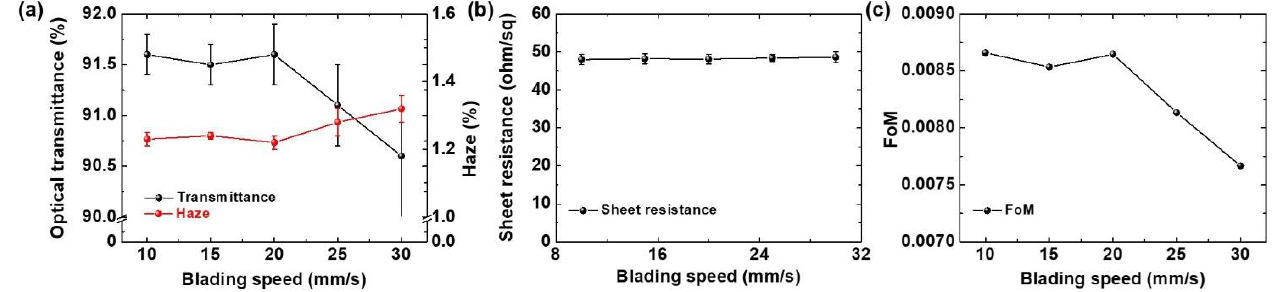
Figure 4. ( a ) Optical transmittance and haze, ( b ) sheet resistance, and ( c ) FoM as a function of the blading speed.